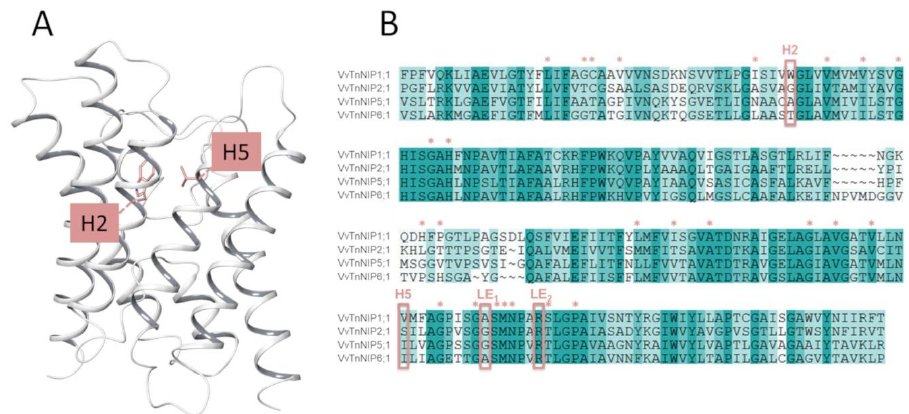
Figure 1. ( A )Representation ofthe grapevineVvTnNIP1;1 structural modelwith H2and H5residuesas pink Figure 1. ( A ) Representation of the grapevine VvTnNIP1;1 structural model with H2 and H5 residues sticks. ( B ) Sequence alignment of grapevine VvTnNIP1;1 (residues 43–259), VvTnNIP2;1 (residues 68–259), as pink sticks. ( B ) Sequence alignment of grapevine VvTnNIP1;1 (residues 43 – 259), VvTnNIP2;1 VvTnNIP5;1 (residues 68–283), and VvTnNIP6;1 (residues 75–292). The aromatic / arginine (ar / R) selectivity (residues 68 – 259), VvTnNIP5;1 (residues 68 – 283), and VvTnNIP6;1 (residues 75 – 292). The filter is framed, and additional conserved channel residues are annotated with stars (*). NIP = Nodulin aromatic/arginine (ar/R) selectivity filter is framed, and additional conserved channel residues are 26-like intrinsic annotated with stars (*). NIP = Nodulin 26-like intrinsic proteins.